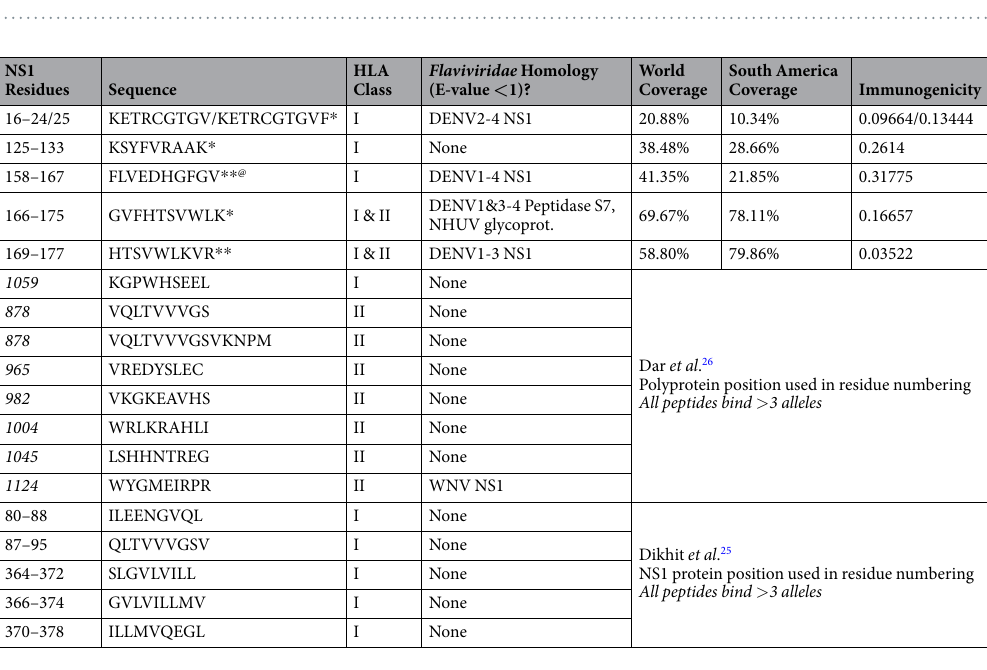
Figure 1. Workflow for ZIKV peptide antigenicity predictions. Briefly, chain A of 5GS6 from the Protein Database was submitted to the IEDB MHC class I and II binding tools and MHC-NP tool. ( a ) Class I results were first filtered by ANN predicted IC 50 levels as recommended in Paul et al . 39 followed by filtering for those results in the top 1 percentile rank. Subsequent results were then sorted by sequence and those predicted to bind ≥ 3 class I alleles were chosen for further analysis. ( b ) Class II results were first filtered for those results in the top 1 percentile rank and then sorted by sequence with those predicted to bind ≥ 2 class II alleles chosen for further analysis. ( c ) MHC-NP initial results were filtered for those hits with a probability score of ≥ 0.8. Cross-referencing of class II and MHC-NP data against class I data was performed to generate putative peptides (Table 1).